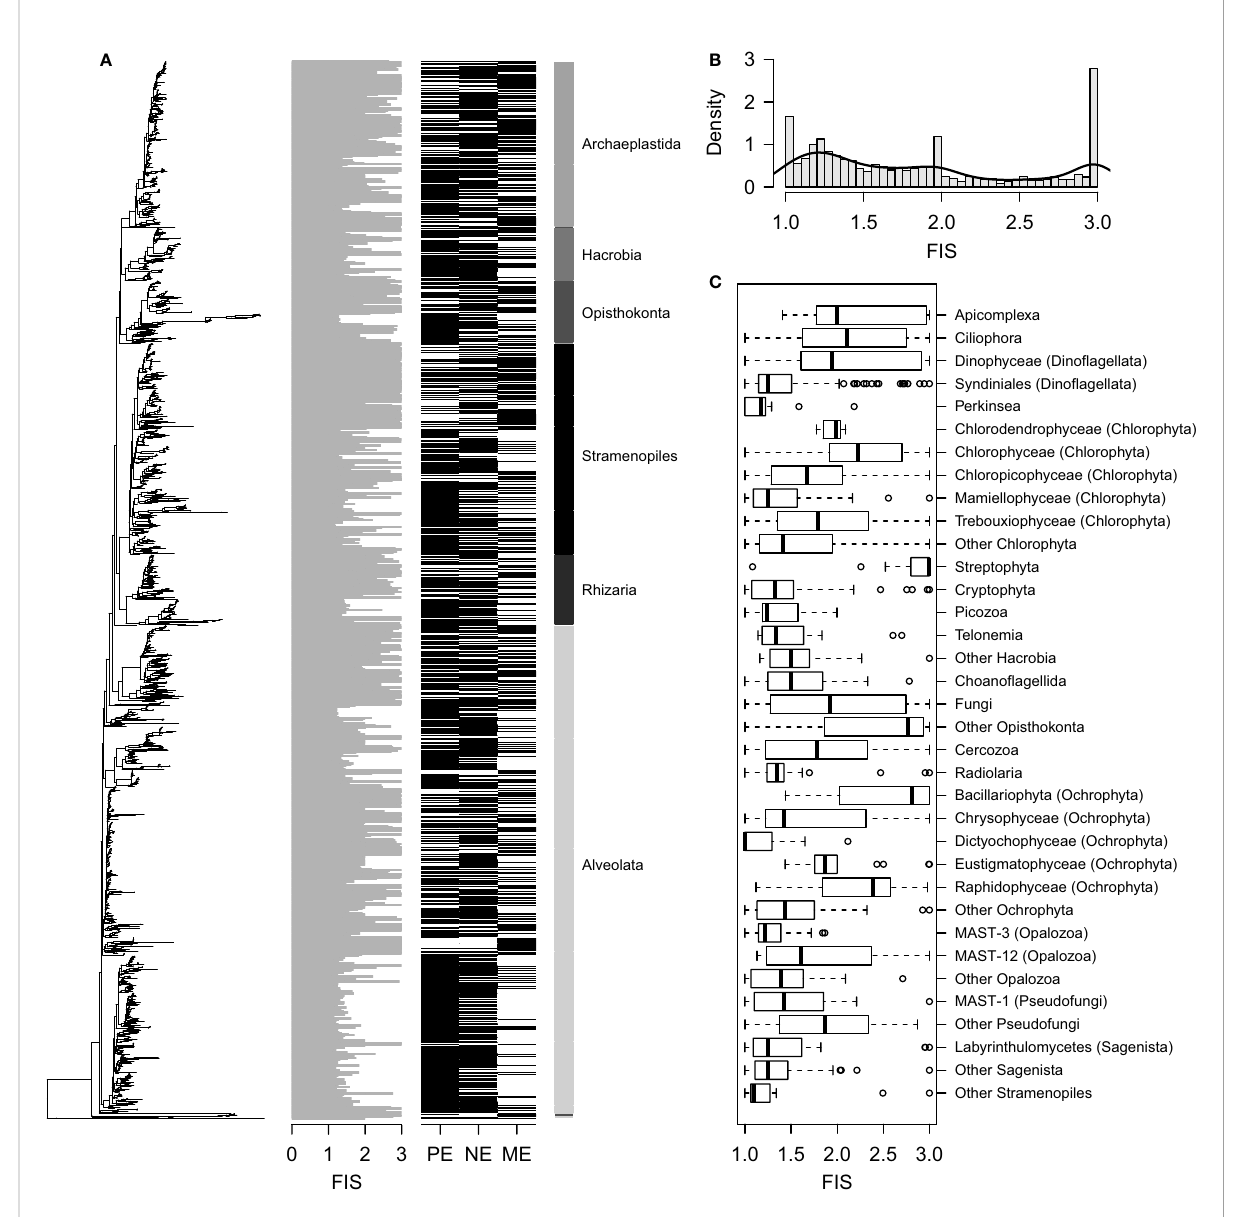
FIGURE 3 (A) Phylogenetic placement of the fraction-inferred size (FIS) index combined with a heatmap showing the ASV occurrence (indicated by the black bars) in each category. Taxonomic assignments at the supergroup level are added on the right side of the heatmap. (B) Histogram showing the distribution of the FIS index. The line indicates kernel density estimates for the FIS frequency. (C) Boxplots indicating the FIS index for the main lineages (generally collapsed at ranks 3 and 4 of the PR 2 database). One Dino fl agellata ASV (FIS = 1.3), which could not be further assigned to a lower taxonomic level (e.g., Syndiniales and Dinophyceae), and the Amoebozoa and Apusozoa supergroups, consisting of just one (FIS = 1.2) and two (FIS = 1.2 and 1.6) ASVs, respectively, were not included in the